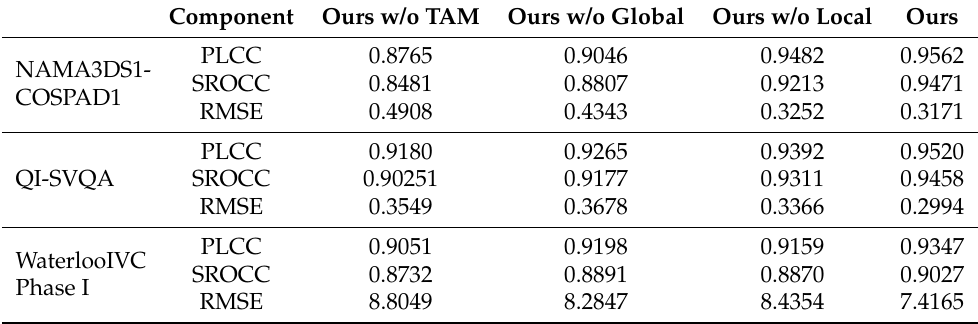
Table 6. Ablation experiments on three